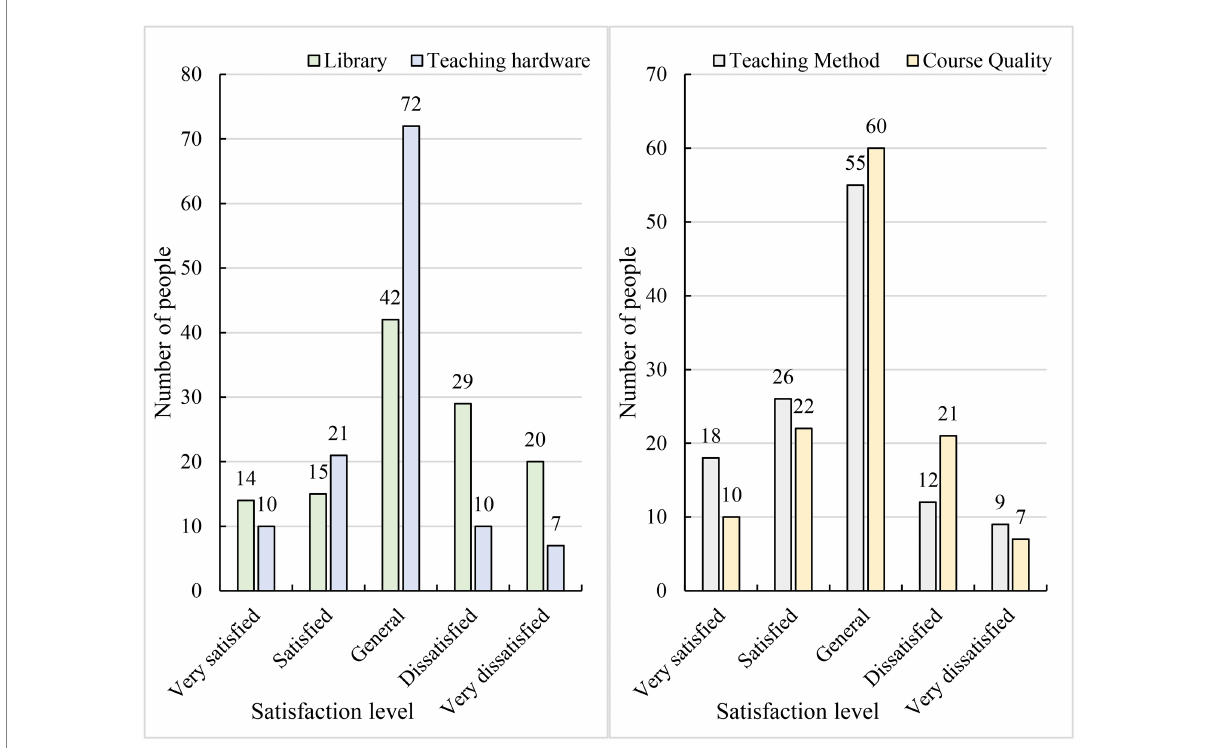
FIGURE 7 Satisfaction survey of overseas students concerning teaching facilities and teaching quality.